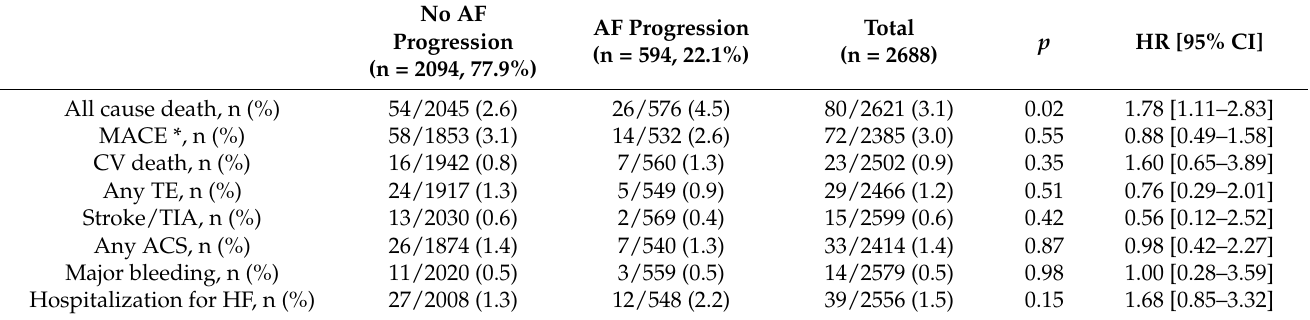
Table 4. Major adverse events at 2 years of follow-up according to AF progression status at 1